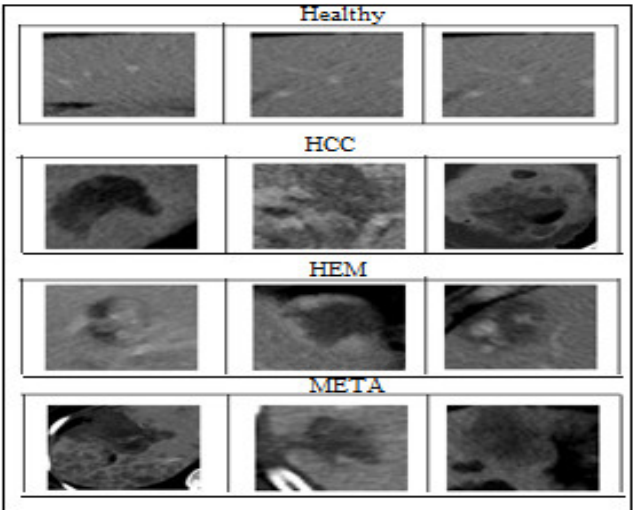
Figure 6. Dataset